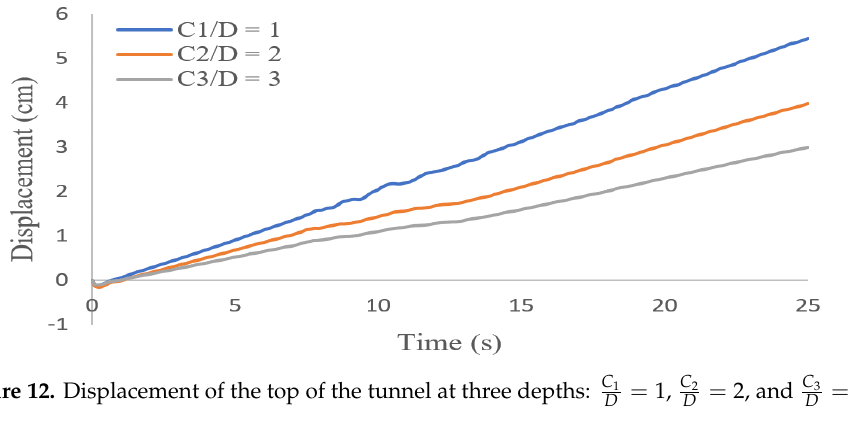
Figure 11. Bending moment created at a node on the tunnel lining.